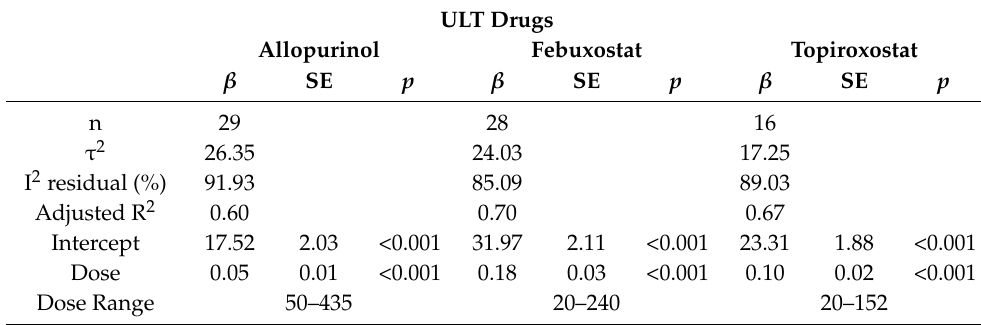
Table 1. Meta-analysis of Serum uric acid-lowering effect of approved uric lowering therapy drugs with daily doses [29–63]. ULT